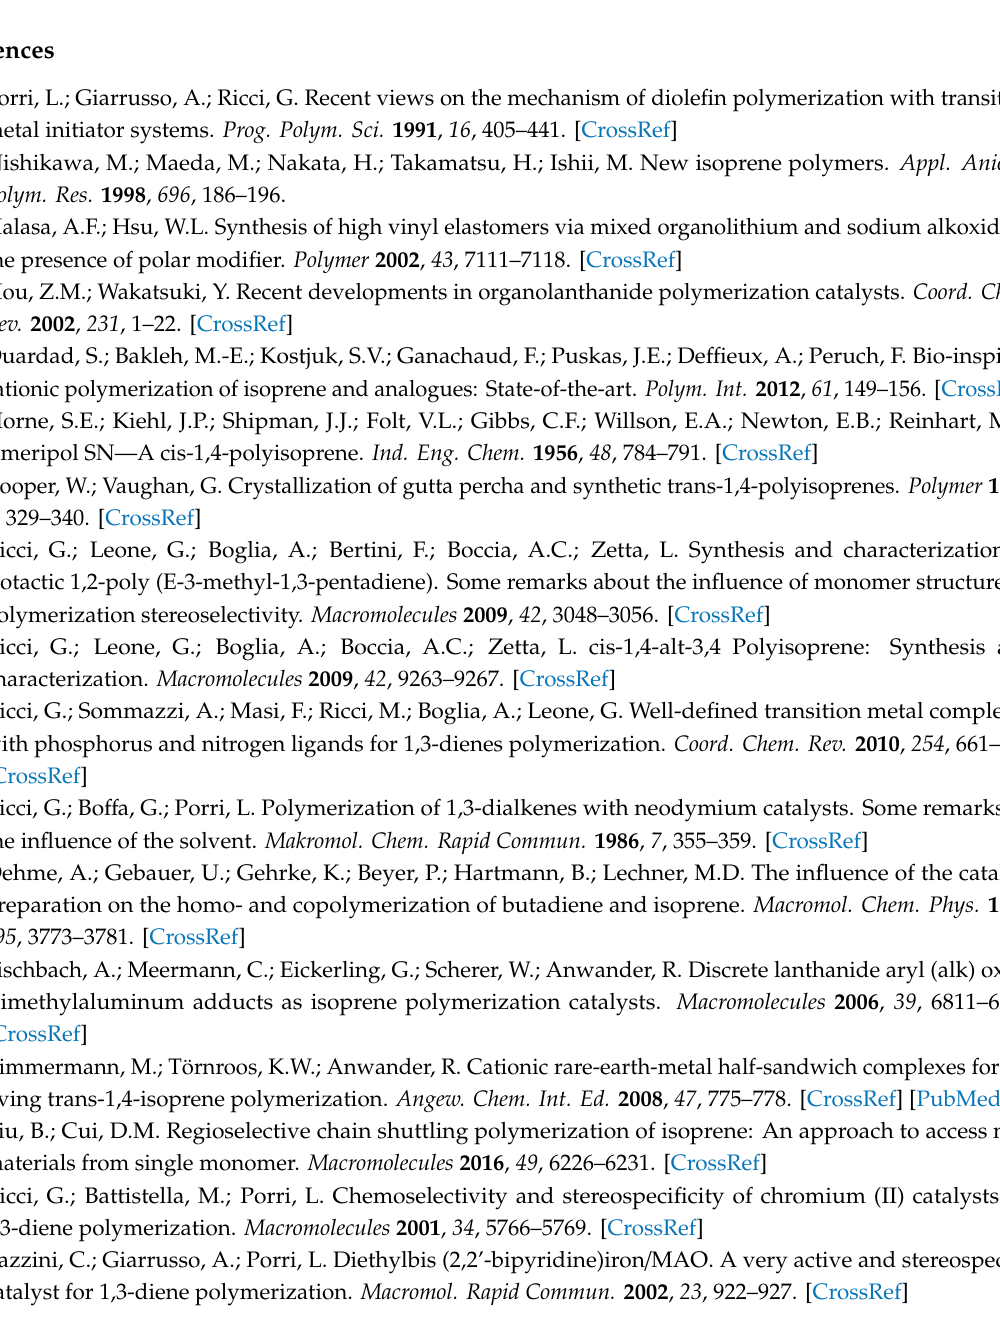
Table S1: E ff ects of cocatalyst and solvent on the isoprene polymerization with VCl 3 catalyst, NMR spectra of the representative polyisoprene and GPC curves of polyisoprene